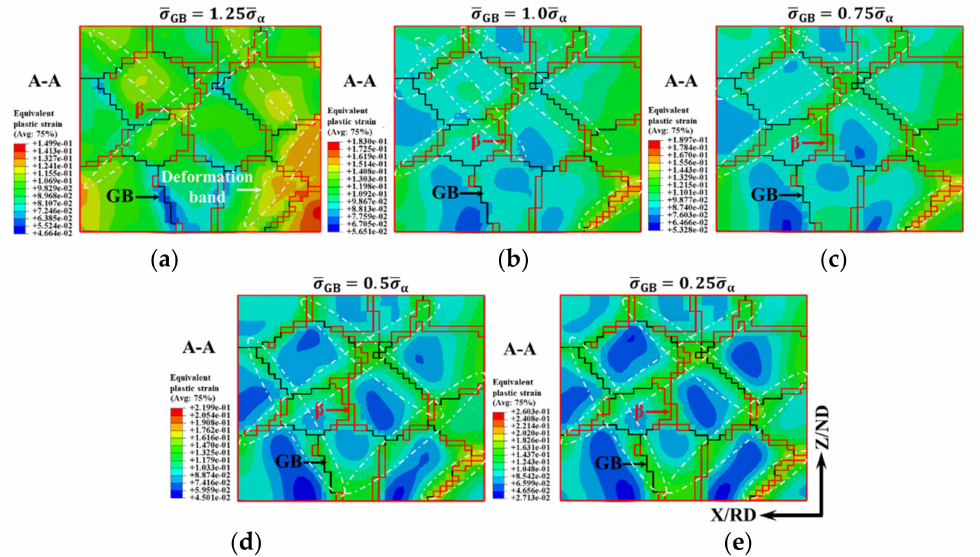
Figure 15. Simulated strain distribution of TA15 tensile samples with different strength relationship of three structures with true strain of 0.1. ( a ) σ GB = 1.25 σ α ; ( b ) σ GB = 1.0 σ α ; ( c ) σ GB = 0.75 σ α ; ( d ) σ GB = 0.5 σ α ; ( e ) σ GB = 0.25 σ α